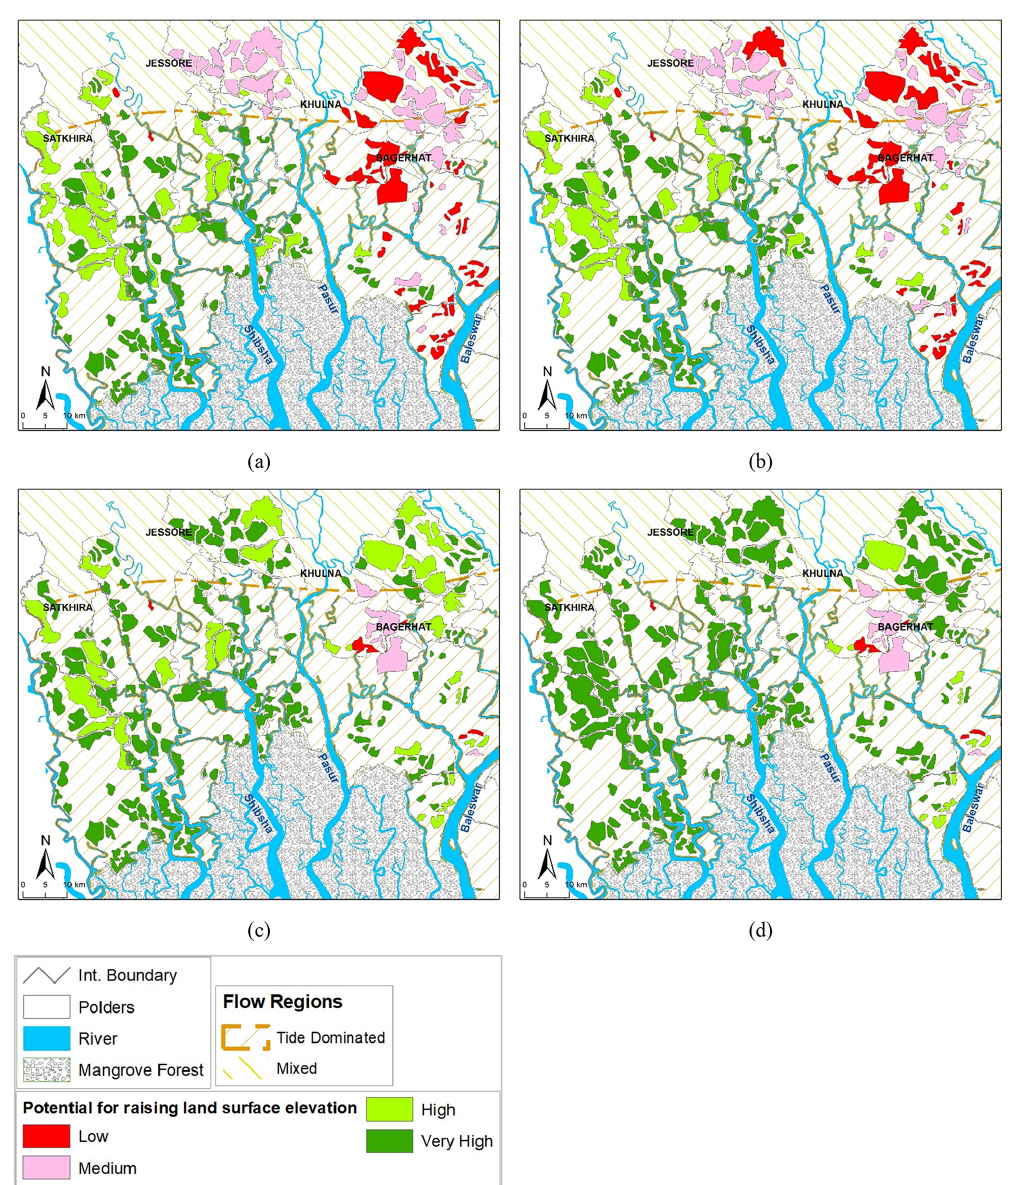
Figure 6. The potential of raising the land surface elevation of beels in southwestern Bangladesh using TRM operation during (a) dry, (b) pre-monsoon, and (c) monsoon seasons and (d) throughout the year. Very high potential is > 5 times RSLR; high is 3–5 times RSLR; medium is 1–3 times RSLR; low potential is < 1 times RSLR (RSLR = 10mmyr − 1